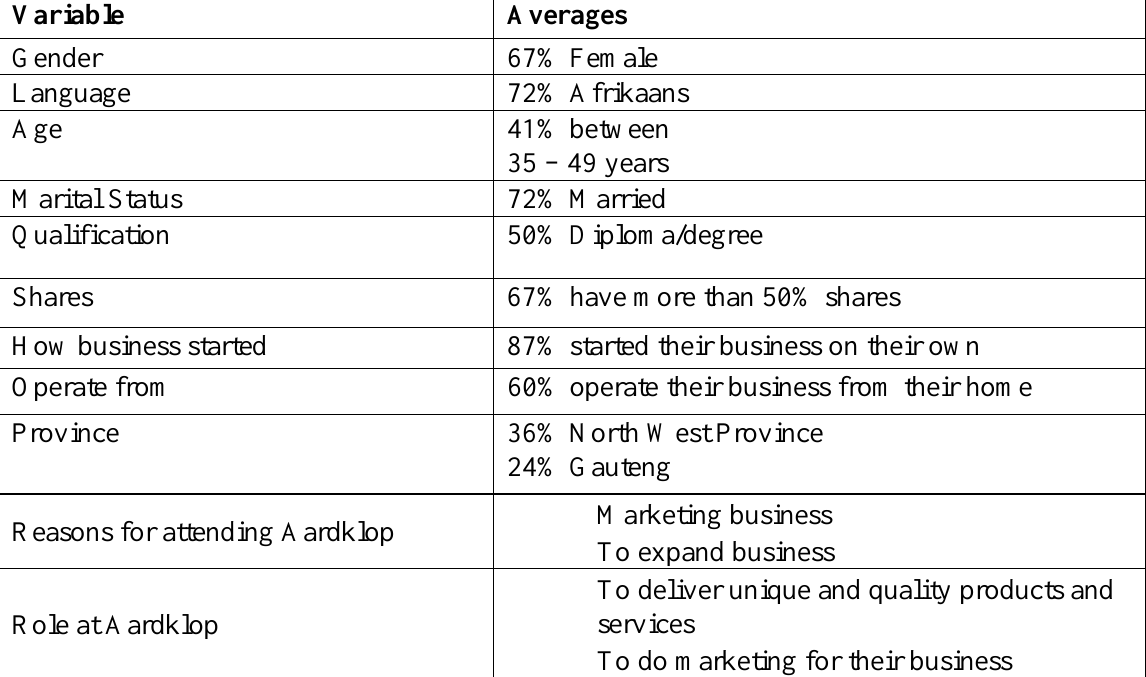
Table 2: Entrepreneurs’ profile: Aardklop National Arts Festival 2007